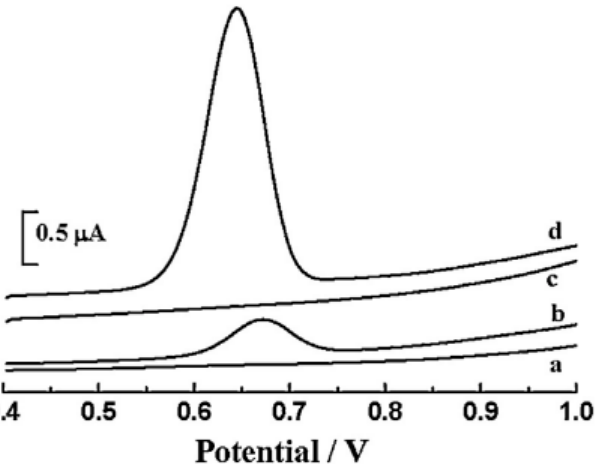
Figure 2. DPV curves of CPE (a and b) and alumina-microfiber-modified CPE (c and d) in pH 6.5 phosphate buffer (a and c) and in the presence of 100 nM Sunset Yellow (b and d). Accumulation was performed at 0.4 V for 2 min. Pulse amplitude: 50 mV, pulse width: 40 ms, scan rate: 40 mV s − 1 . Reprinted with the permission of Reference [20]. [License Number 5067491296846].